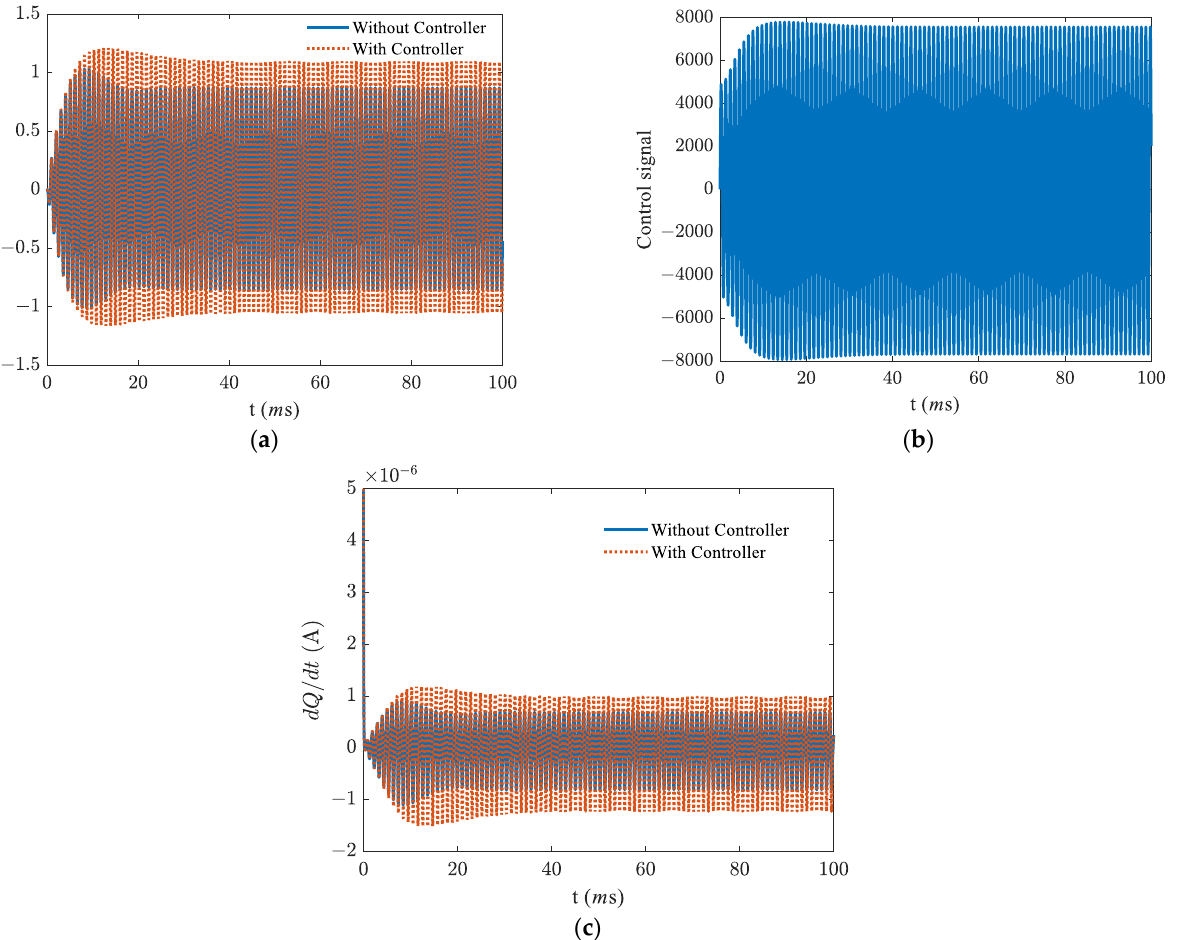
Figure 6. The response in region I, in the presence and absence of the saturation in the PID controller. ( a ) time response, ( b ) feedback signal, and ( c ) current.